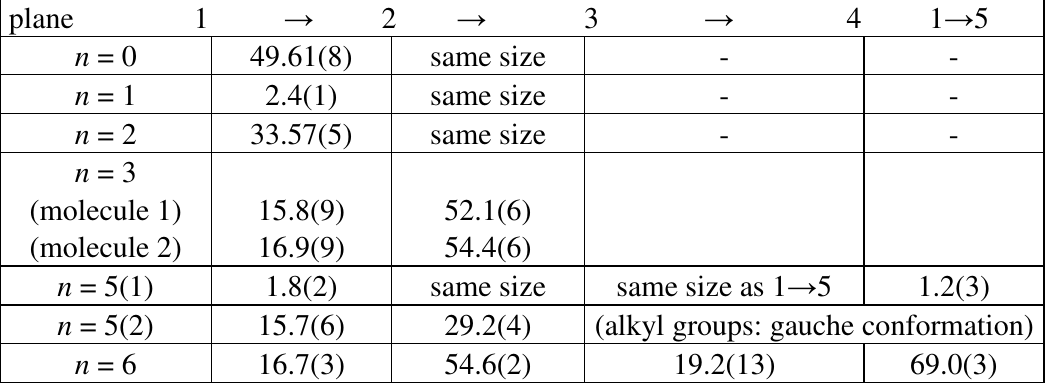
Figure 24. Representation of the packing arrangement of TBAA-0 in three projections on